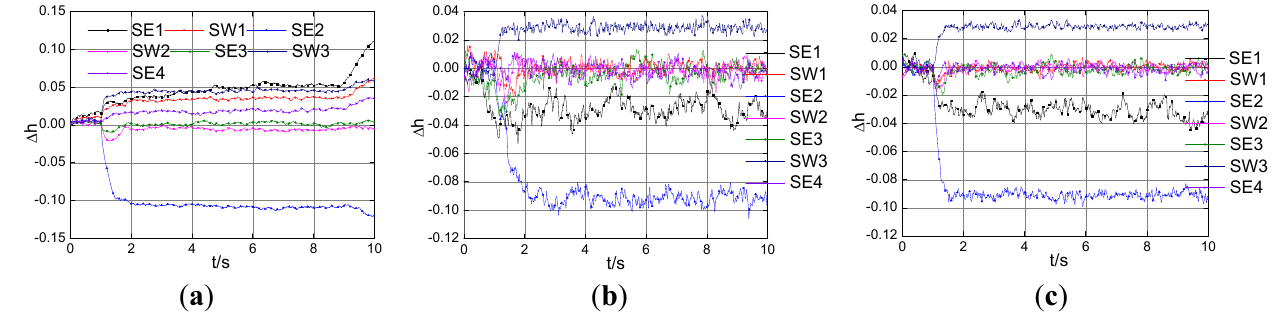
Figure 6. Health parameters estimation with non-Gaussian process noise under the Fault 2.